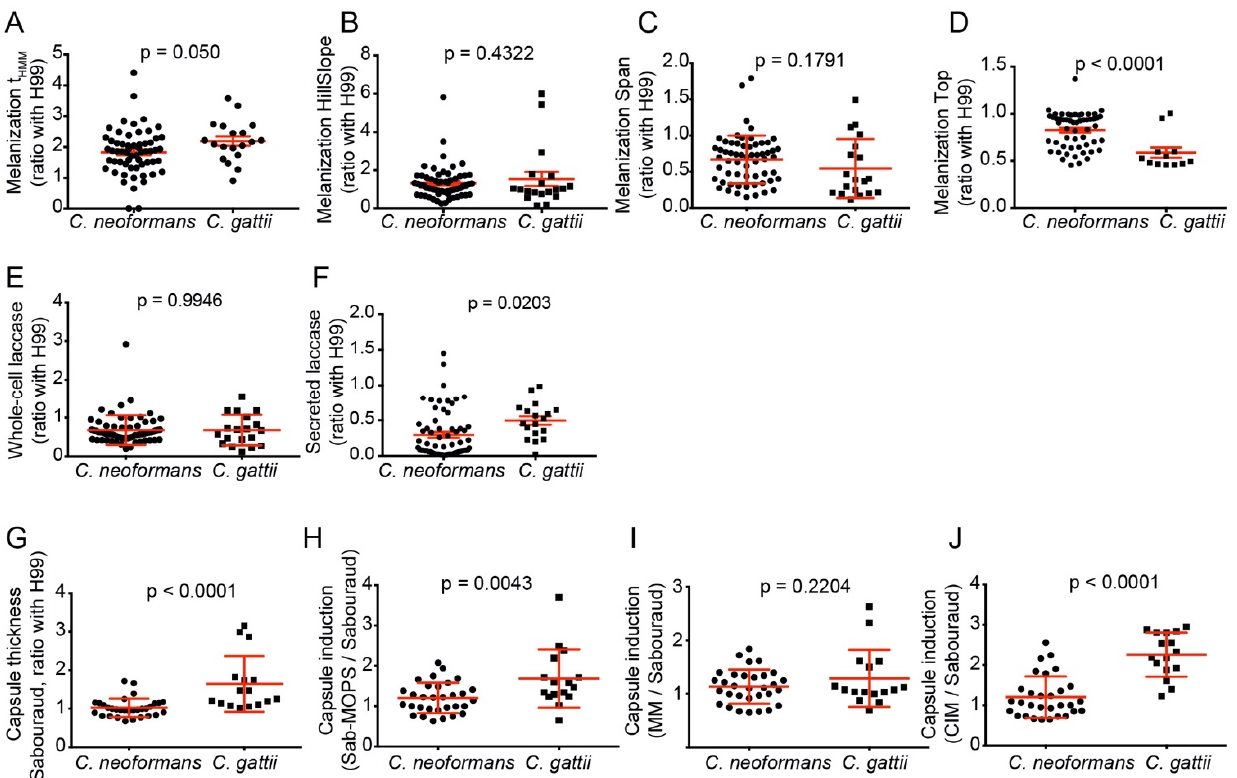
Figure 4. Differences in melanization, laccase production and capsule thickness between C. neoformans and C. gattii clinical isolates. ( A–D ) Differences in t HMM (time for half-maximum melanization); melanization Hill Slope (slope of the sigmoidal curve at the inflection point, proportional to how fast the colony melanizes); melanization Span (difference in median gray levels of the colony at the beginning and end of the experiment—difference between top and bottom) and melanization Top (median gray level of the colony image at the end of the experiment—proportional to how dark the colony turned), C. gattii , n = 19 and C. neoformans n = 60. ( E,F ) Differences in secreted laccase activity ( C. gattii , n = 18; C. neoformans , n = 64) and whole-cell laccase activity ( C. gattii , n = 19; C. neoformans , n = 65). ( G ) Capsule thickness in Sabouraud medium (Sab) ratio with H99. ( H–J ) Capsule induction in Sab-MOPS, minimum medium (MM) and CO 2 -independent medium relative to Sabouraud ( C. gattii , n = 16; C. neoformans , n = 32). Experiments were repeated at least twice and had similar results. To compare the groups, we used a two-tailed t -test for independent samples.